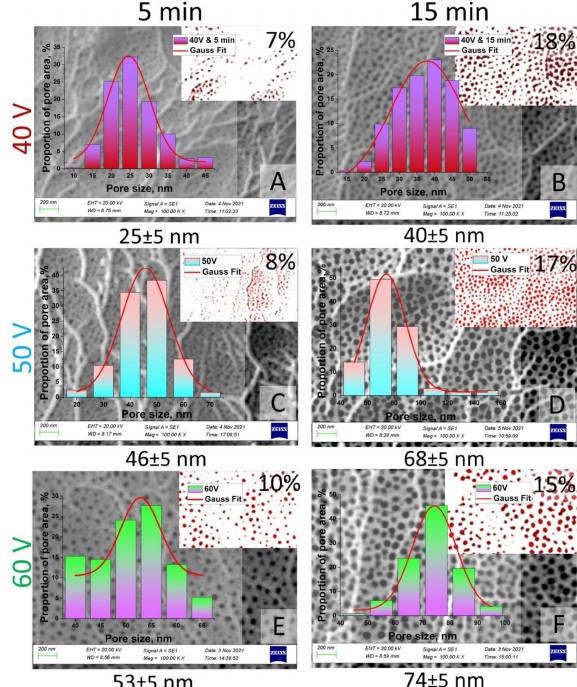
Figure 6. SEM images (contrast SEM images of porosity—red and white) and pore size histograms of the I type samples after chemical modification: ( A )—Sample No. 1 after chemical etching during 5 min; ( B )—Sample No. 1 after chemical etching during 15 min; ( C )—Sample No. 2 after chemical etching during 5 min; ( D )—Sample No. 2 after chemical etching during 15 min; ( E )—Sample No. 3 after chemical etching during 5 min; ( F )—Sample No. 3 after chemical etching during 15 min.